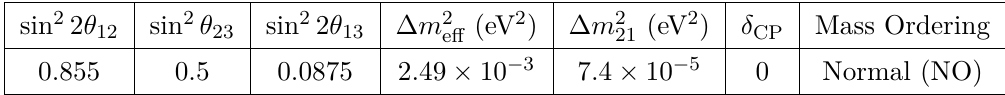
Table 2 . The benchmark values of neutrino oscillation parameters used in this analysis. These values are consistent with the present neutrino global fits [59–62]. Normal mass ordering indi- cates m 1 < m 2 < m 3